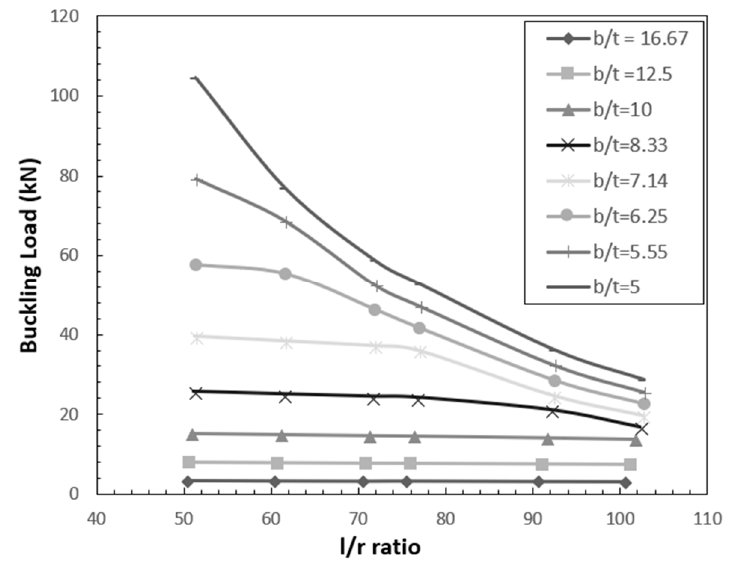
ff ect of slenderness ratio and width-to-thickness ratio on buckling Figure 8. Effect of slenderness ratio and width-to-thickness ratio on buckling load. Figure 8. E